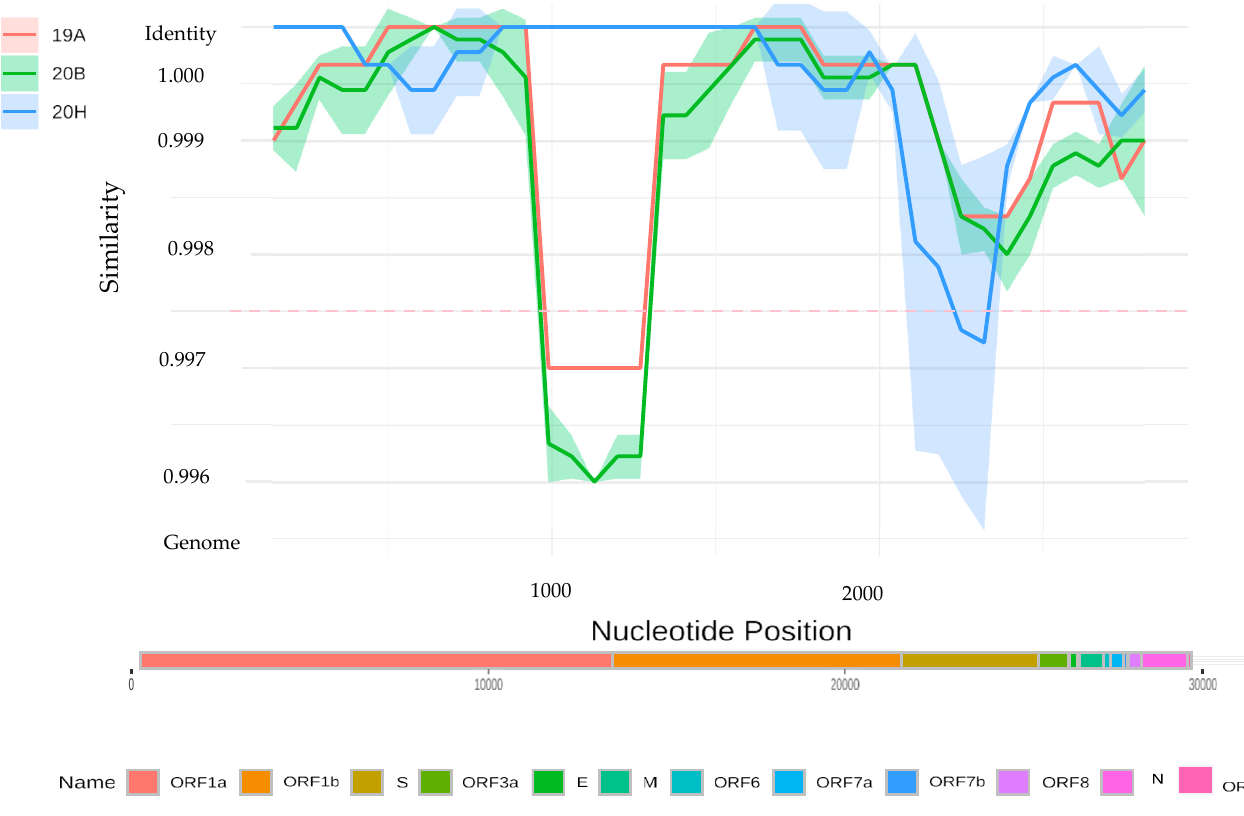
Figure 5. Identity plot of a putative recombinant sequence from Cat-103.